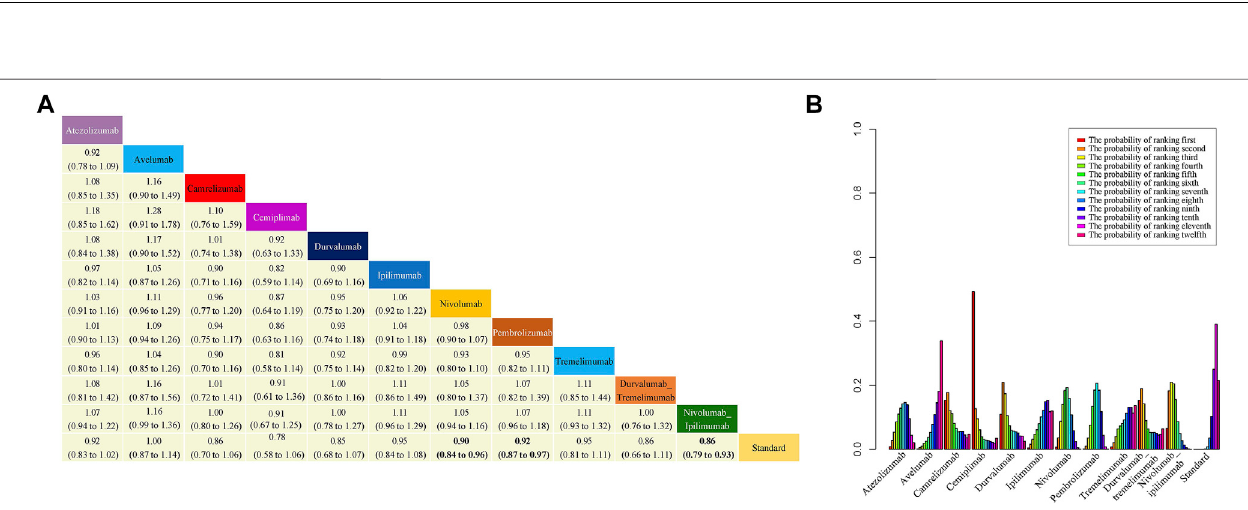
FIGURE4| ResultsofNMA,safetypro fi le (A) andprobabilityrankingdiagram (B) .Inthesafetypro fi le,ef fi cacyoftreatmentforoverallsurvival(OS)isrepresentedas HRs with 95% con fi dence intervals. All comparisons are made as column versus row. Statistically signi fi cant results are in bold. Probability ranking diagram shows the probability of the safety of different therapies ranking the fi rst to the last for